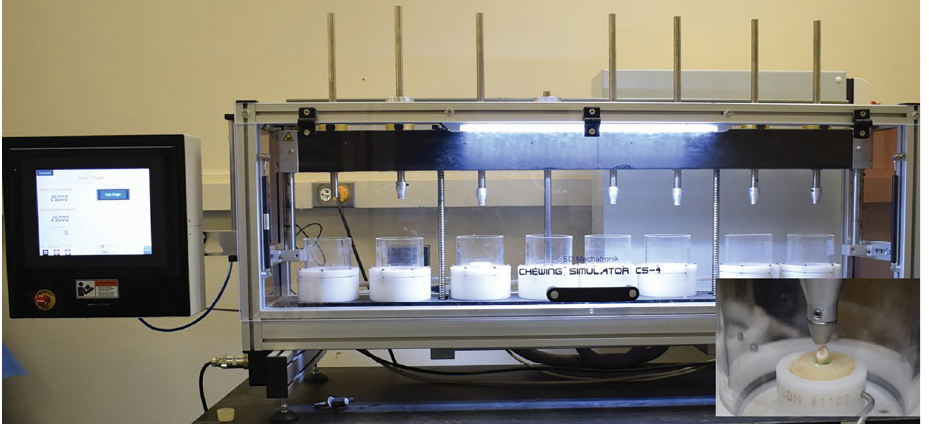
Figure 3. Masticatory simulation